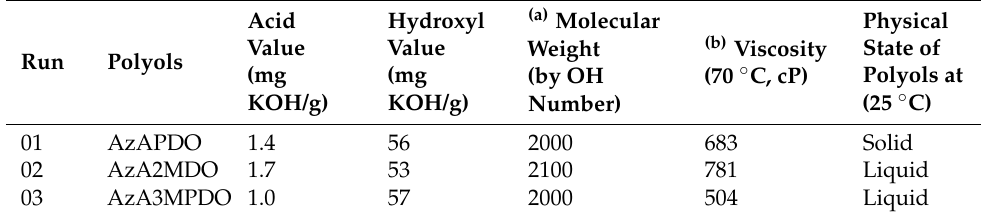
Table 2. Properties of polyester polyols.